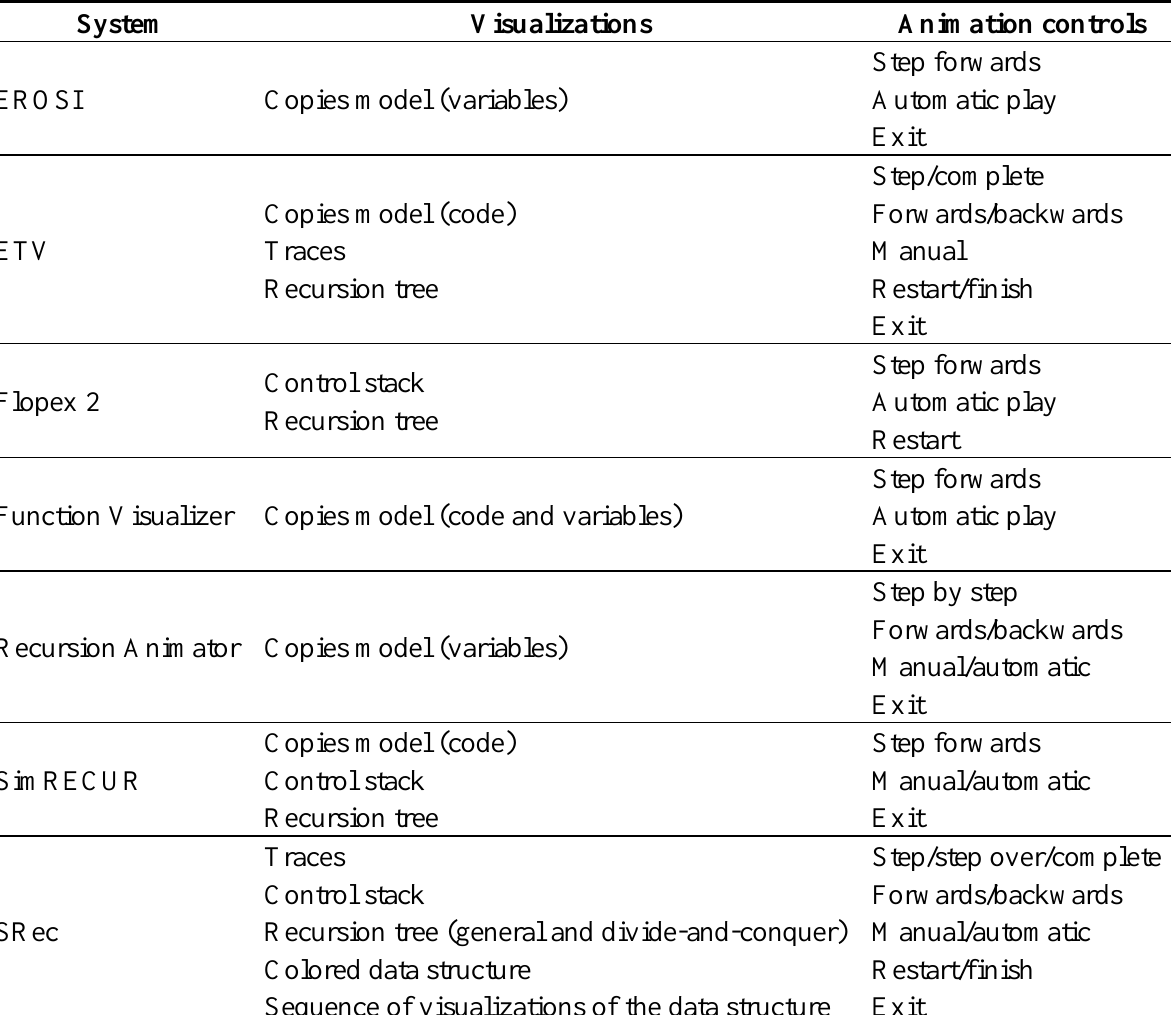
Table 1. Comparison of visualization and animation features in several animation systems of